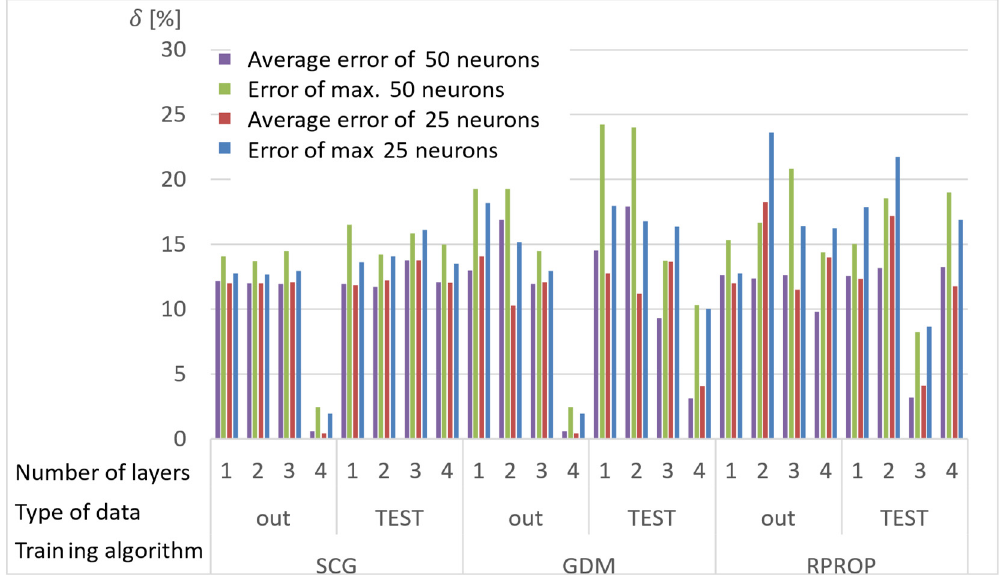
Figure 8. Maximum and average relative error for selected structures of neural networks and training algorithms after the second training cycle.